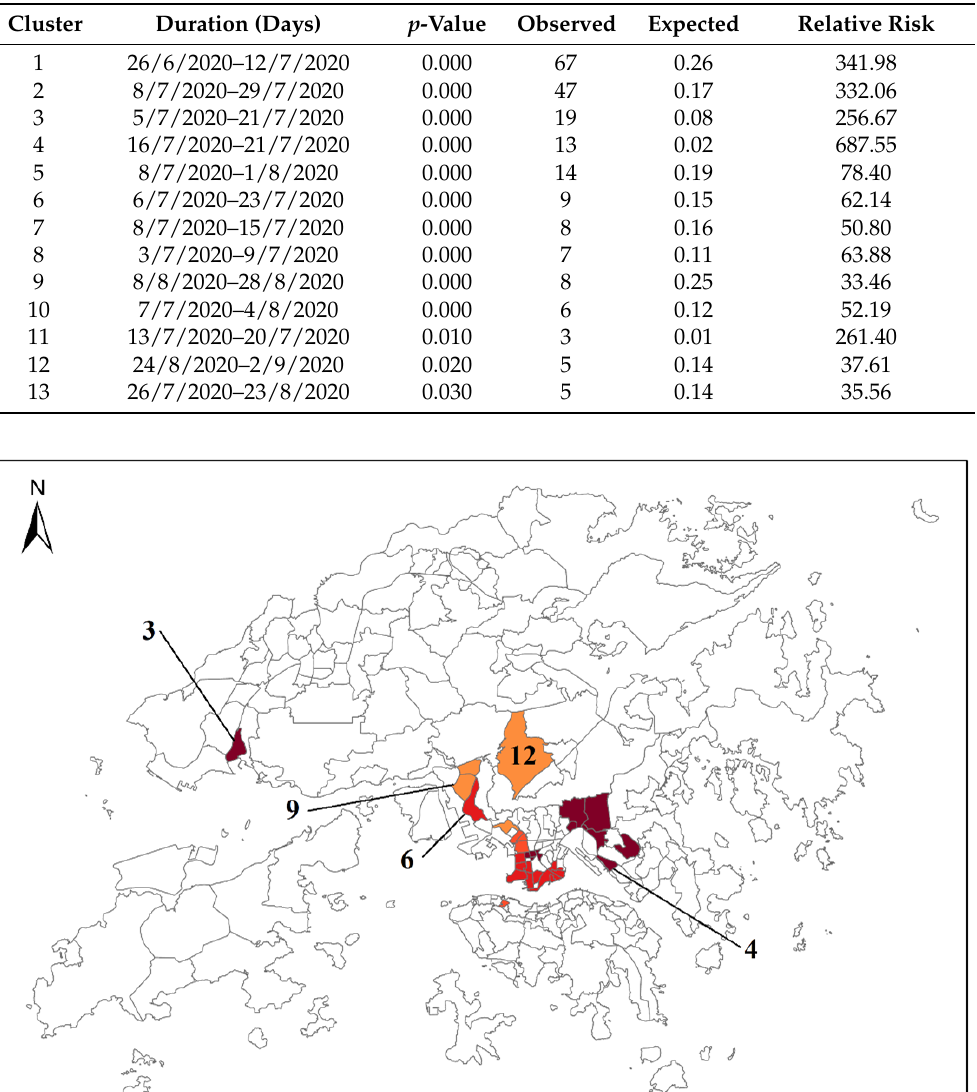
Table 7. Space–time clusters in stage II of COVID-19 transmission in non-residential locations in Hong Kong.